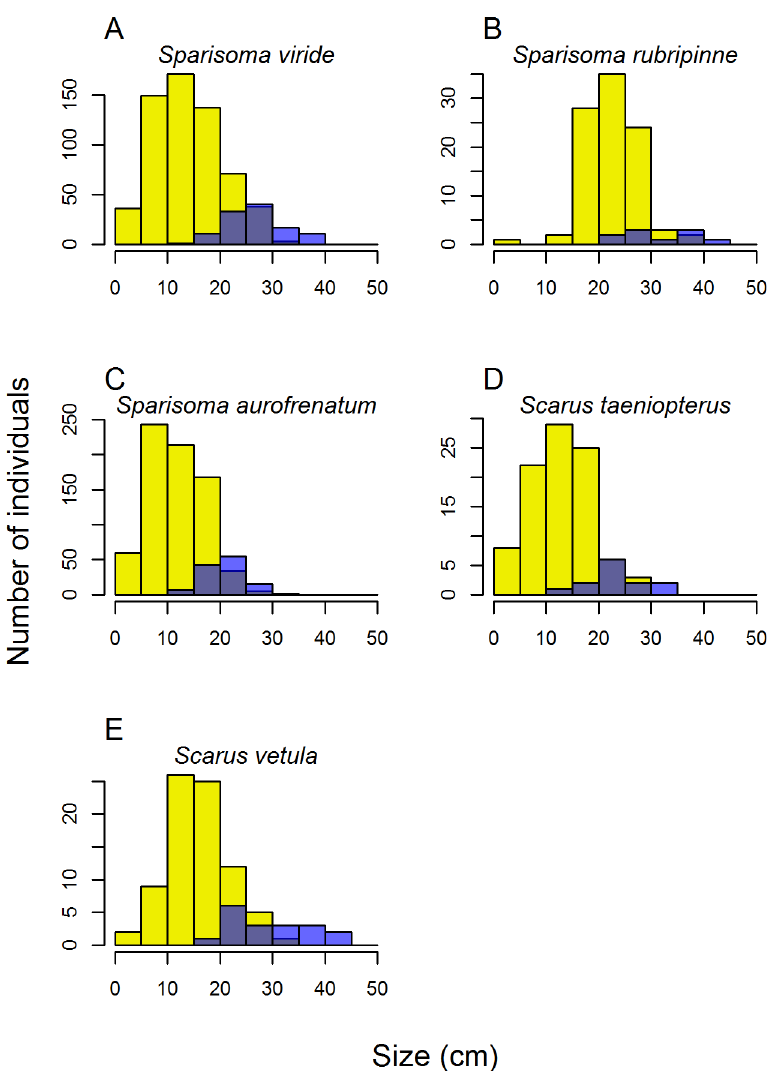
Fig 5. Size-frequency plots for the five most common species of large parrotfish around Barbuda. Gray bars represent juvenileand female fish, blue bars represent terminal phasemales, gray represents overlap. Note that y-axis scale changeswith each